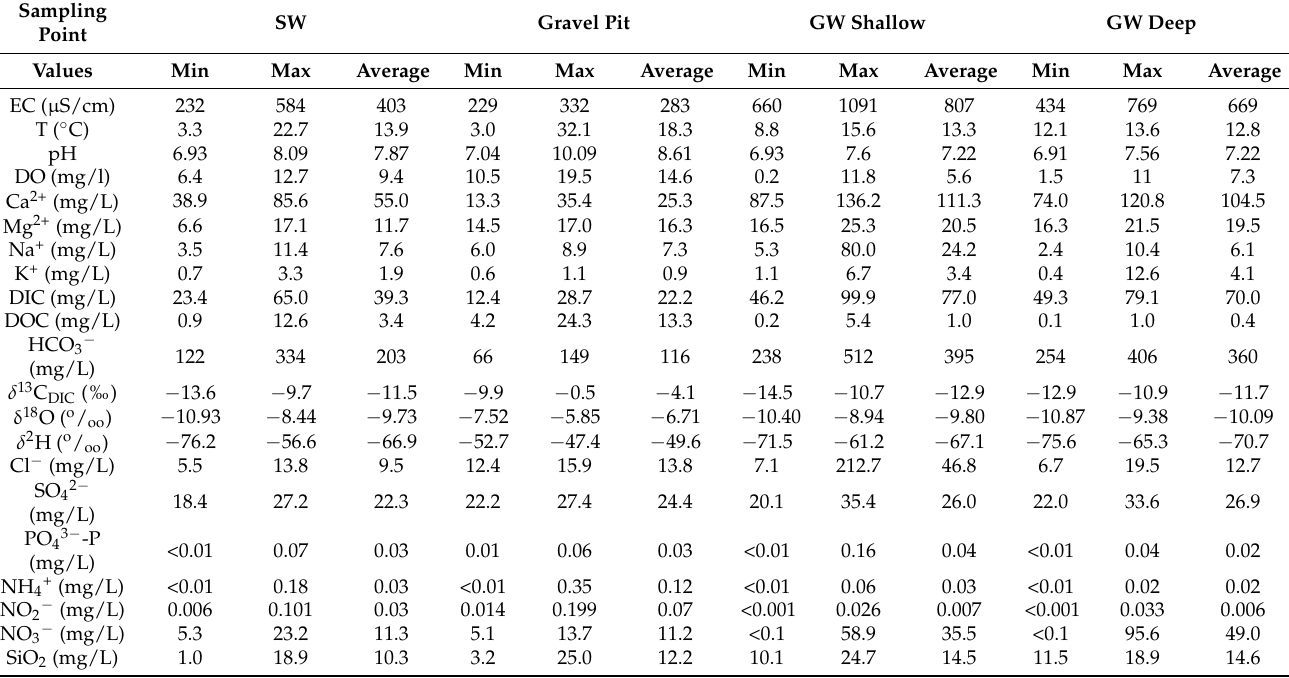
Table 2. The minimum, maximum, and average physical, physicochemical, chemical, and isotopic parameters for surface water (SW) and groundwater (GW) for five sampling